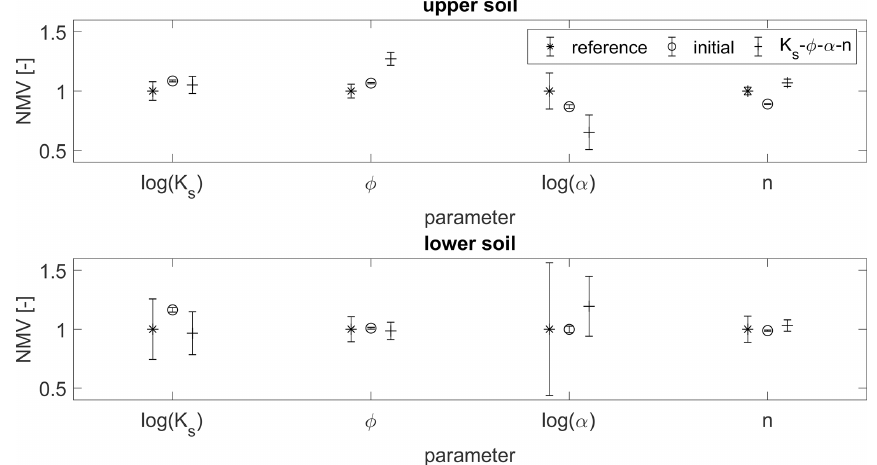
Figure 15. Statistics (mean and standard deviation) of the parameter fields of the two heterogeneous soil layers. All values are normalized by the mean value of the reference field. The statistics of the ensemble runs refer to the estimated parameter field (ensemble mean).